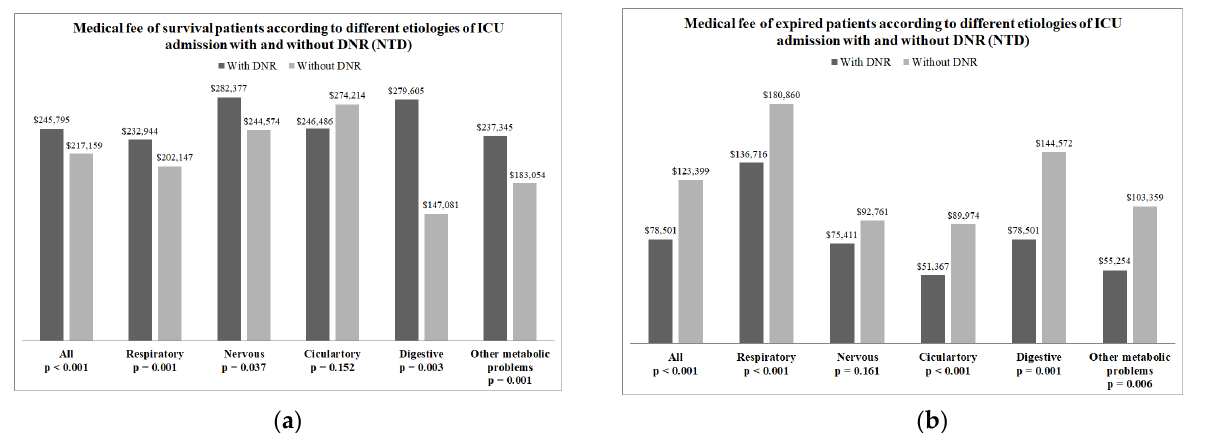
Figure 3. ( a ) The median medical fee (NTD) of all patients who survived and those with different etiology for ICU admission after 1:4 propensity score matching; ( b ) the median medical fee (NTD) of all patients who died and those with different etiology for ICU admission after 1:4 propensity score matching. NTD: New Taiwan Dollar.